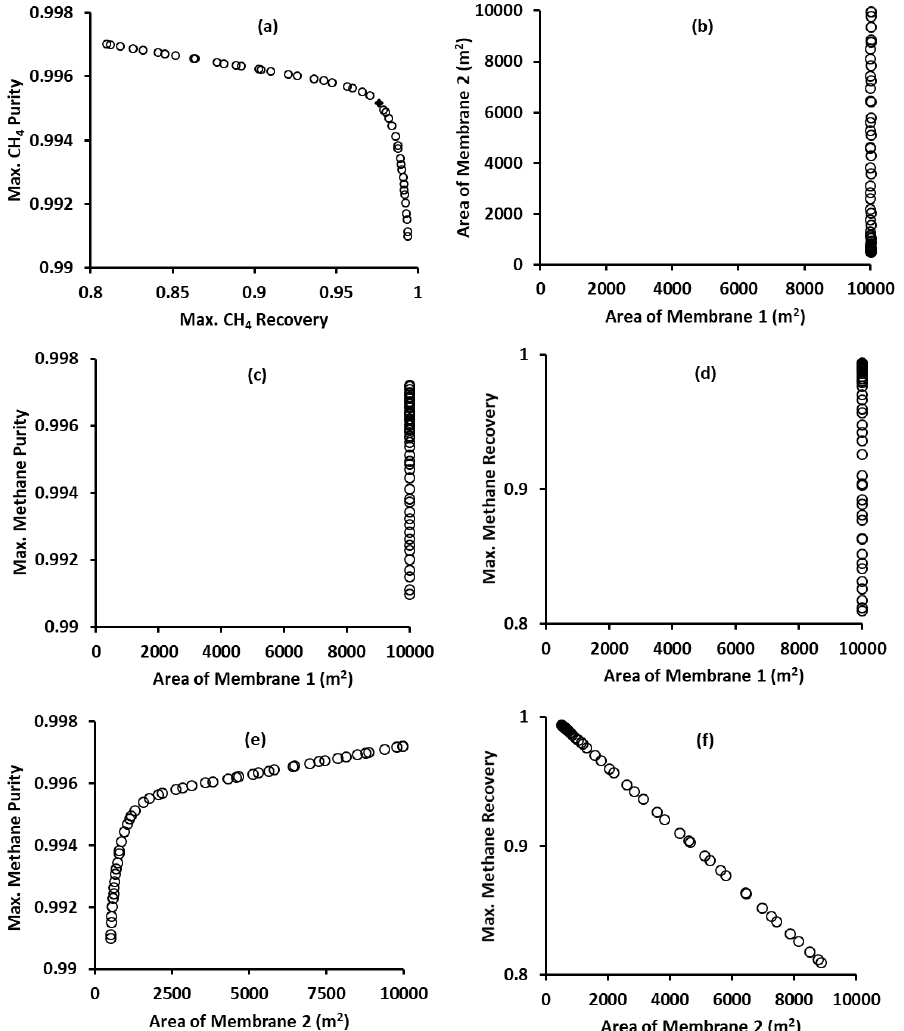
Figure 2. Pareto optimal (non-dominated) solutions for optimizing a two-stage membrane separation process for CO 2 removal from natural gas: ( a ) objective space showing the trade-off between two objectives, ( b ) decision variable space showing optimal values of decision variables, and ( c ) to ( f ) variation of one objective function (methane purity or recovery) with decision variables (membrane 1 and 2 areas).